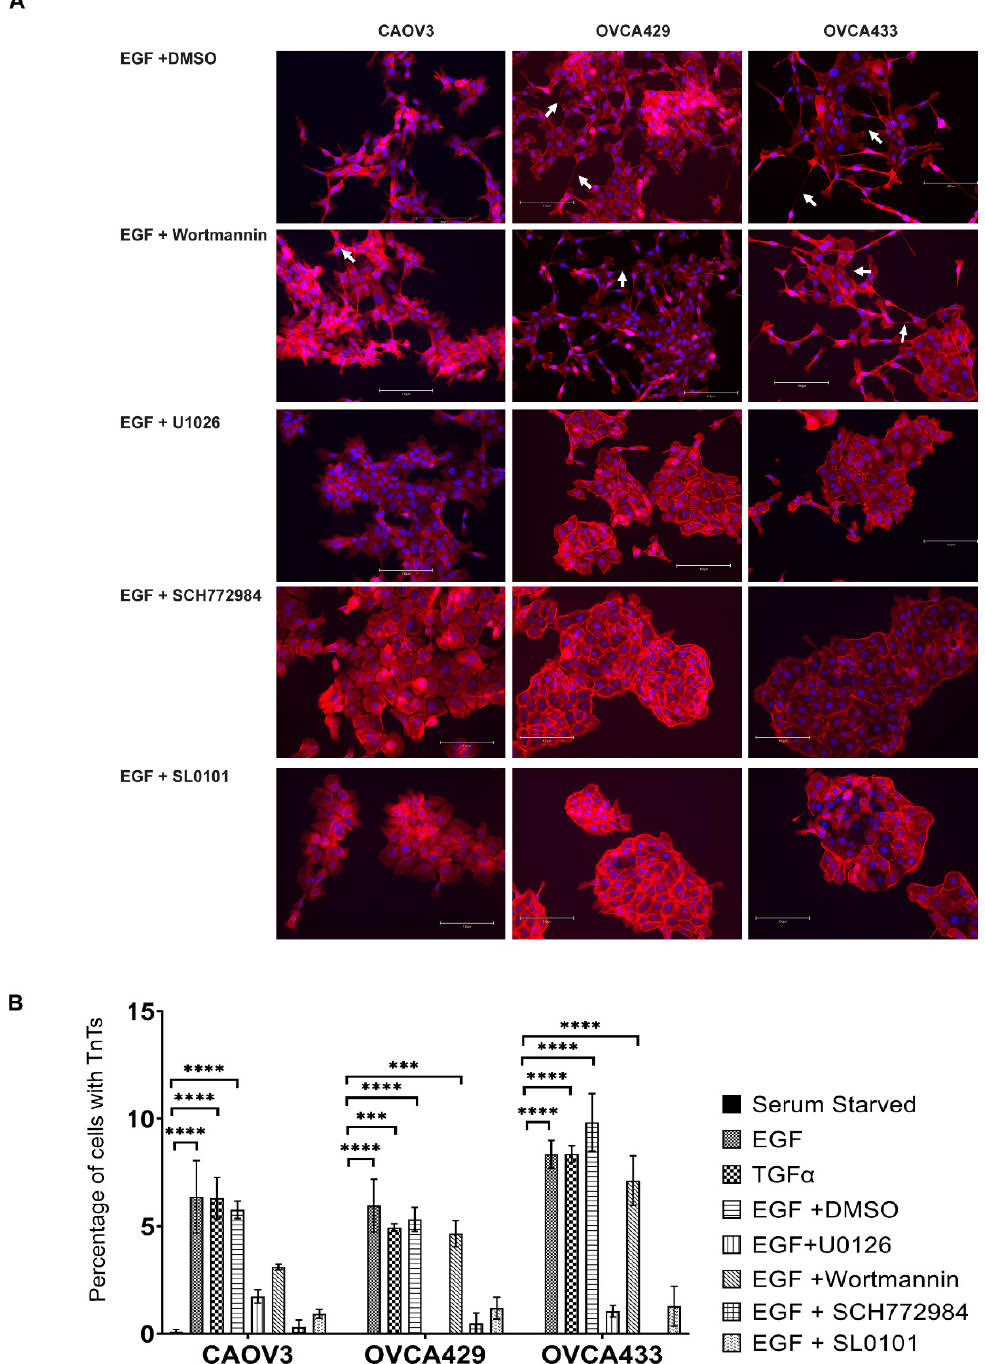
Figure 5. TnT formation requires MAPK activity. To determine if MAPK or PI3K signaling pathways contributed to TnT formation down stream of EGFR activity OCCs were treated with EGF and pathway inhibitors. ( A ) CAOV3, OVCA429, and OVCA433 cells were serum starved for 24 h and then treated for an additional 24 h with 20 nM EGF + DMSO, EGF + Wortmannin (PI3K inhibitor), EGF + U0126 (MEK inhibitor), EGF + SCH772984 (ERK inhibitor), or EGF + SL0101 (RSK inhibitor). Cells were stained with Texas Red Phalloidin to visualize F-actin based structures and DAPI (blue). Each experiment was performed in triplicate and a minimum of 3 fields of cells were analyzed for each treatment. ( B ) Total cell numbers and number of TnTs were counted for each field. Counts were averaged and error bars denote SEM between at least 3 biological replicates. For statistics, comparisons are between the EGF + DMSO and EGF + treatment. Arrow = TnT. *** p < 0.001, **** p <